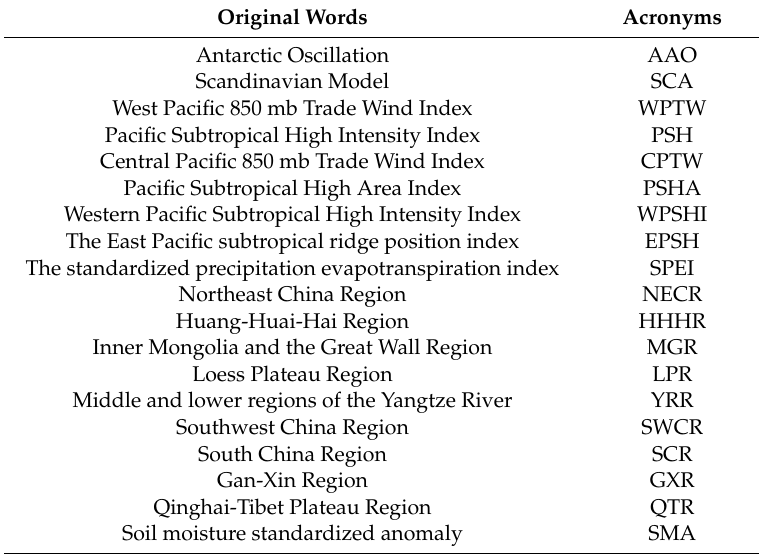
Table 2. Acronyms used in the